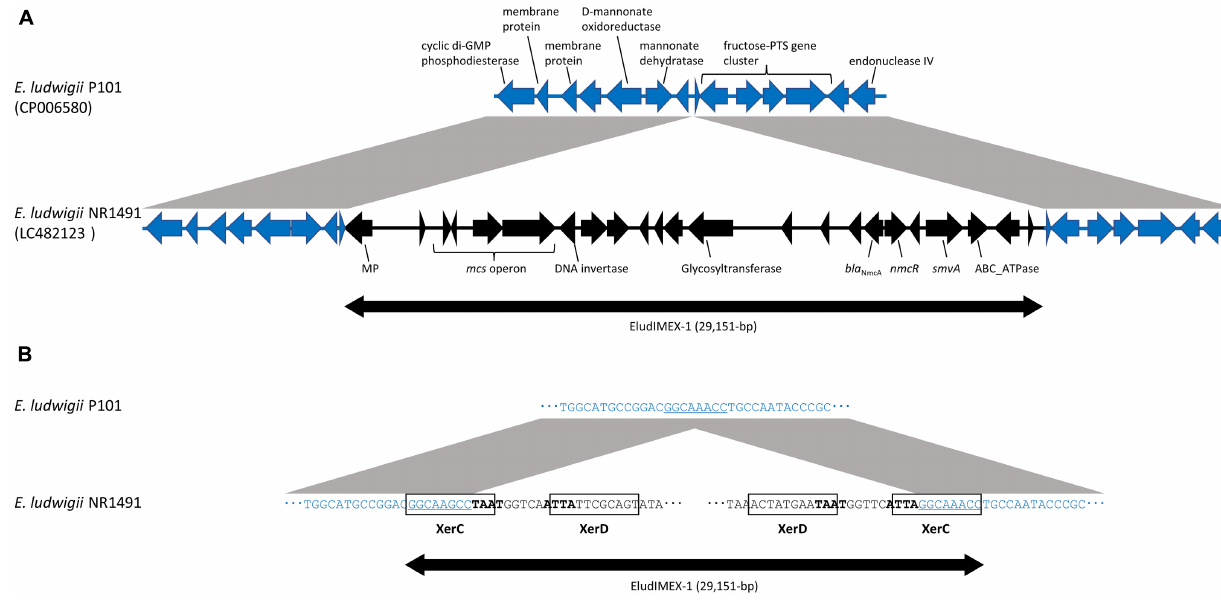
FIGURE 1 | Schematic representations and nucleotide sequences of the genetic elements surrounding EludIMEX-1 of E. ludwigii NR1491 (GenBank accession no. LC482123) and the corresponding region of E. ludwigii P101 (GenBank accession no. CP006580). (A) Schematic representation of the genetic region of E. ludwigii NR1491 (black arrow) and E. ludwigii P101 (blue arrow). The gray regions between the NR1491 and P101 indicate > 99% nucleotide sequence identity. Insertion of the EludIMEX-1 element (double-headed arrow) in E. ludwigii NR1491 was observed. (B) Nucleotide sequences at the junctions of EludIMEX-1 (a part of left and right of the junctions) of E. ludwigii NR1491 and the corresponding region of E. ludwigii P101. The XerC/XerD binding sites are boxed, the conserved regions are boldfaced, and the consensus repeat sequences in XerC binding site of E. ludwigii NR1491 and corresponding sequences of E. ludwigii P101 are indicated using underlined letters.